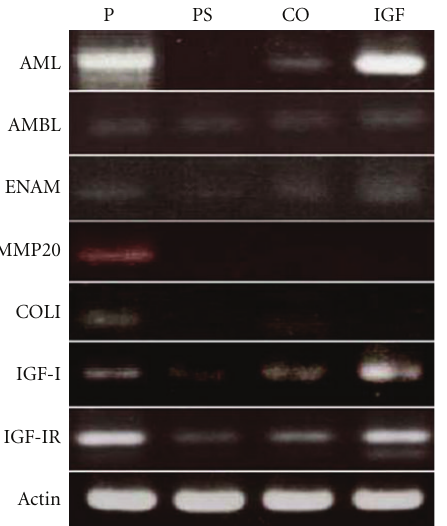
Figure 3: Semiquantitative reverse transcription-polymerase chain reaction analysis of enamel organ-derived epithelial (EOE) cells cultured on insulin-like growth factor-I/insulin-like growth factor binding protein-3/vitronectin complex (IGF) in comparison with the mixed cells from the primary culture (P), and EOE cells on polystyrene (PS) and collagen- type-I-(Co)- coated dishes. Amel- ogenin (AML), ameloblastin (AMBL), enamelin (ENAM), matrix metalloprotease-20 (enamelysin, MMP20), collagen I (COLI), insulin-like growth factor-I (IGF-I), insulin-like growth factor I receptor (IGF-IR), and beta-actin (Actin) in cultured EOE cells were examined. Primary cells (P) expressed all the examined genes. Cultured EOE cells at passage 1 on PS expressed ameloblastin and enamelin. The expression pattern in the IGF culture was similar to that of the CO culture. Both IGF-I and IGF-IR were more strongly expressed in IGF compared to